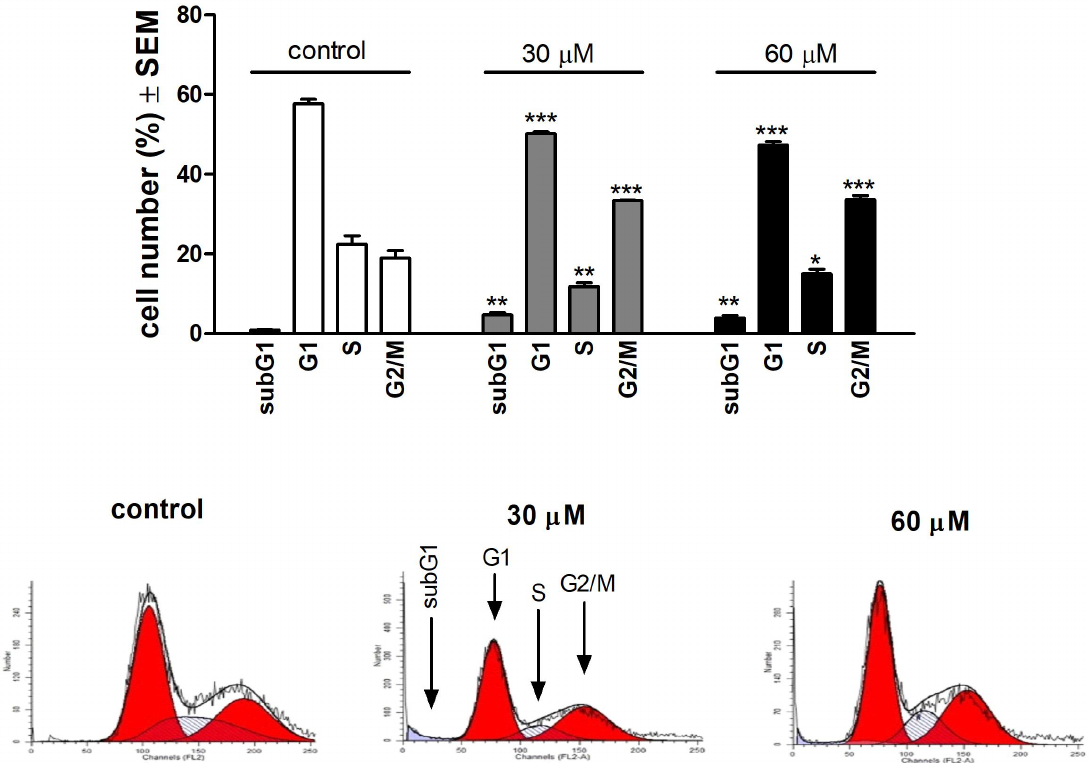
Figure 2. Upper panel: effects of API on the A375 human melanoma cell cycle after incubation for 24 h. Results are mean values ± SEM from three measurements. *, ** and *** indicate p < 0.05, p < 0.01 and p < 0.001 as compared with the control cells, respectively. Lower panel: representative histograms.